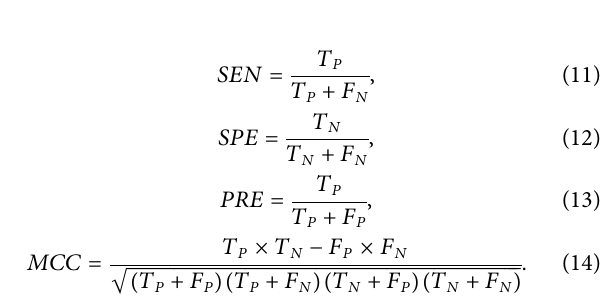
Frontiers in Bioengineering and Biotechnology |